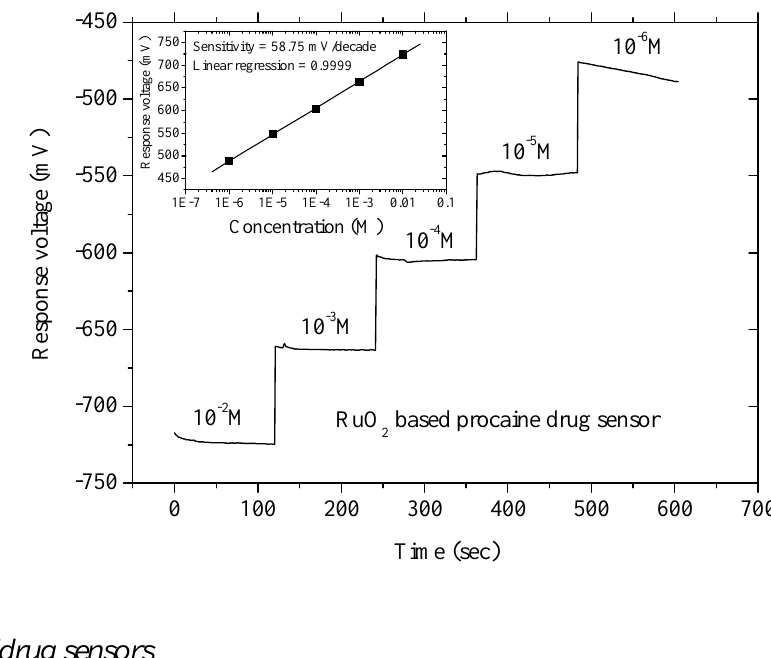
Figure 3 . Response voltage versus time characteristics and sensitivity of ruthenium dioxide based procaine drug sensor from 10 -2 M to 10 -6 M